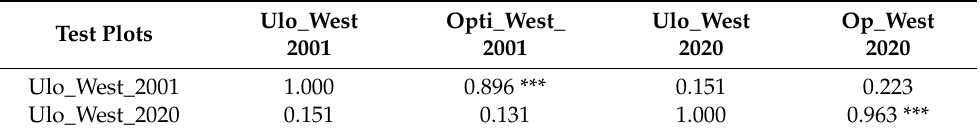
Table 2. Cluster analysis: correlation based on the number of species in 2001 and 2020 on the west roof, 10-cm media. High significance between species in 2001 on both media (Ulo and Opti). Also high significance in 2020 on both media. Time is more important than the different media. Test